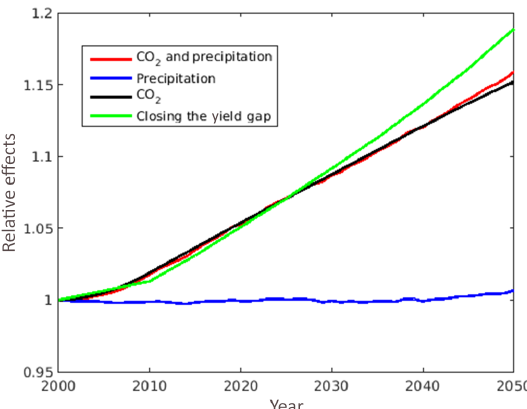
Figure B2. The relative contributions of CO 2 , precipitation, and yield gap closure to the increase in NPP over the greater Sahel region, 2000–2050. Results for CO 2 and precipitation are from RCP6.0 and yield gap is from SSP2. Simulated climate and CO 2 effects shown here are mean effects over the five GCMs (GFDL, MIROC, Hadley, NorESM, IPSL).